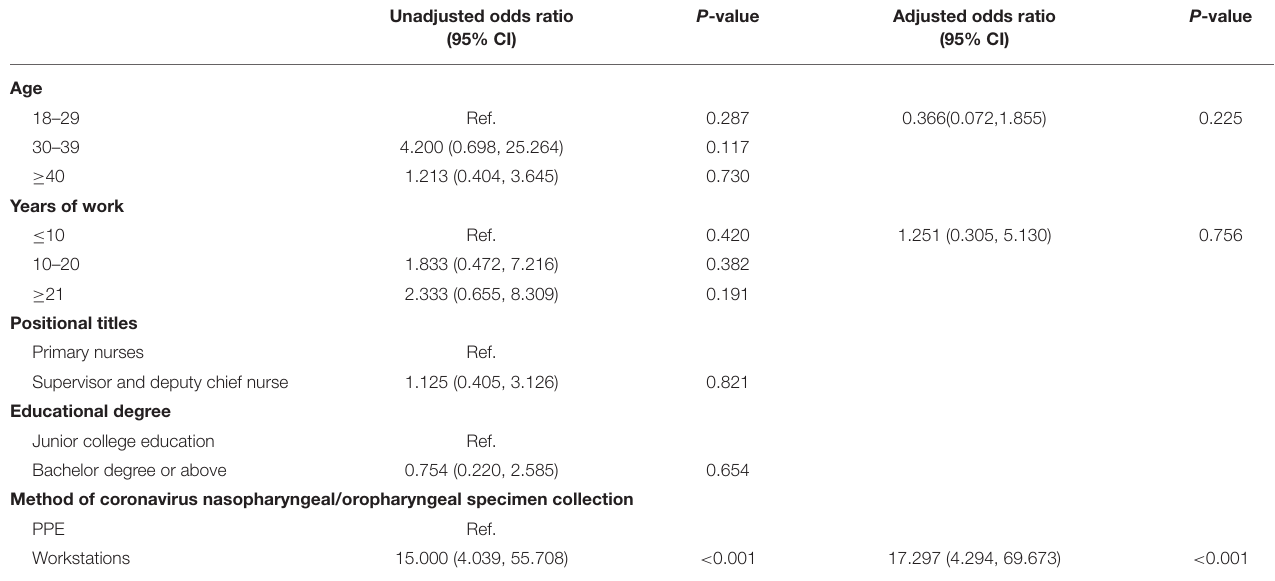
TABLE 2 | Bivariate and multivariate analysis of comfort of working environment.